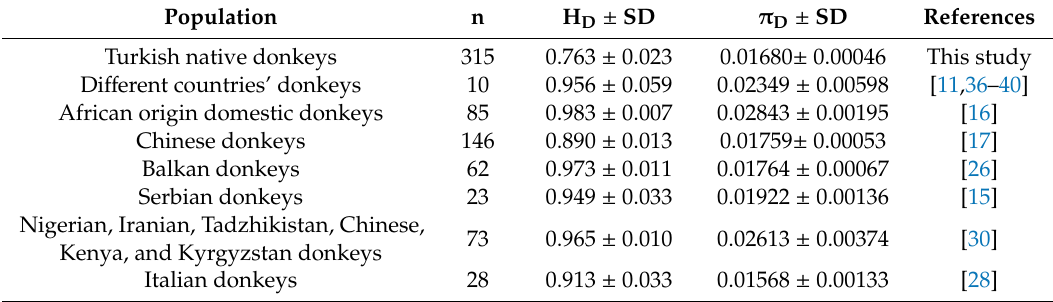
Table 5. The haplotype and nucleotide diversity of mtDNA D-loop within di ff erent countries’ donkey